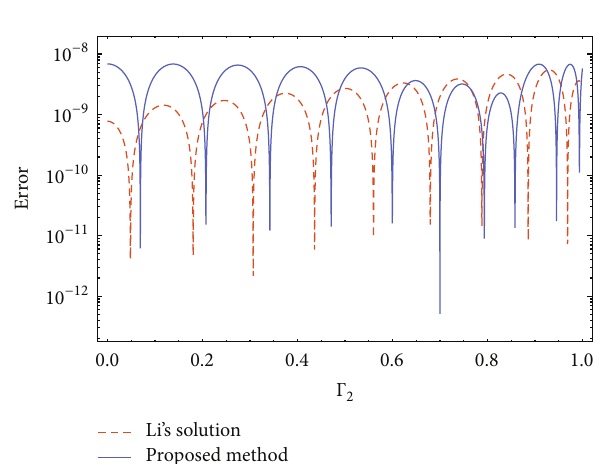
Figure 6: Errors along Γ 2 , where the Dirichlet boundary condition 𝑢 = 500 is specified.